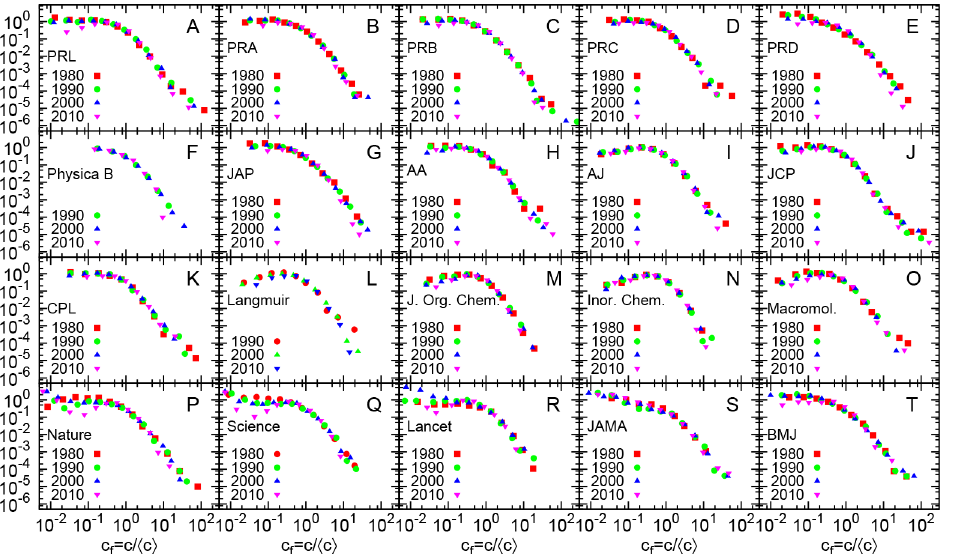
Fig 3. Rescaled probability distributions of citation for academic journals for different years. Probability distribution P (c) of citations c rescaled by average number of citations h c i to publications from from 4 different years (1980, 1990, 2000, 2010) for several academic journal. For any journal, the data for different years seem to follow the same